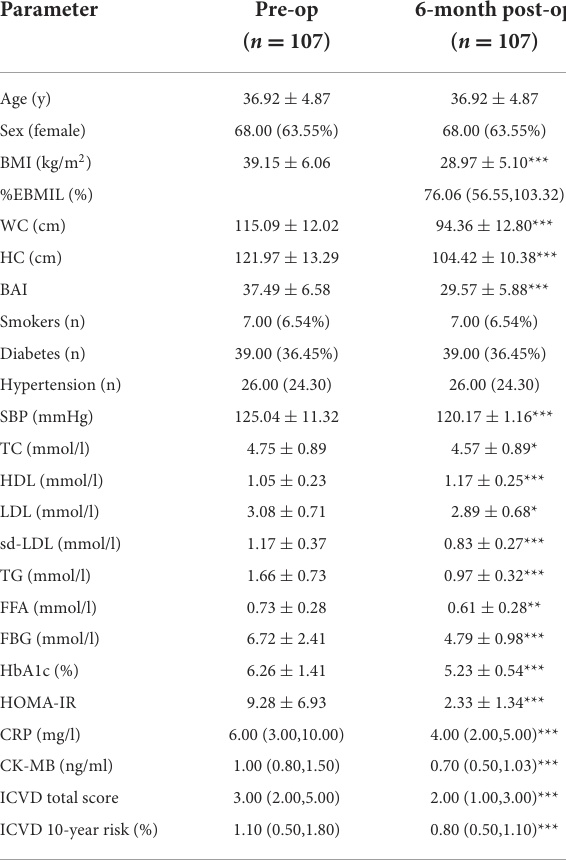
TABLE 1 Pre-operative and 6-month-post-operative demographic and clinical characteristics of participants. Parameter